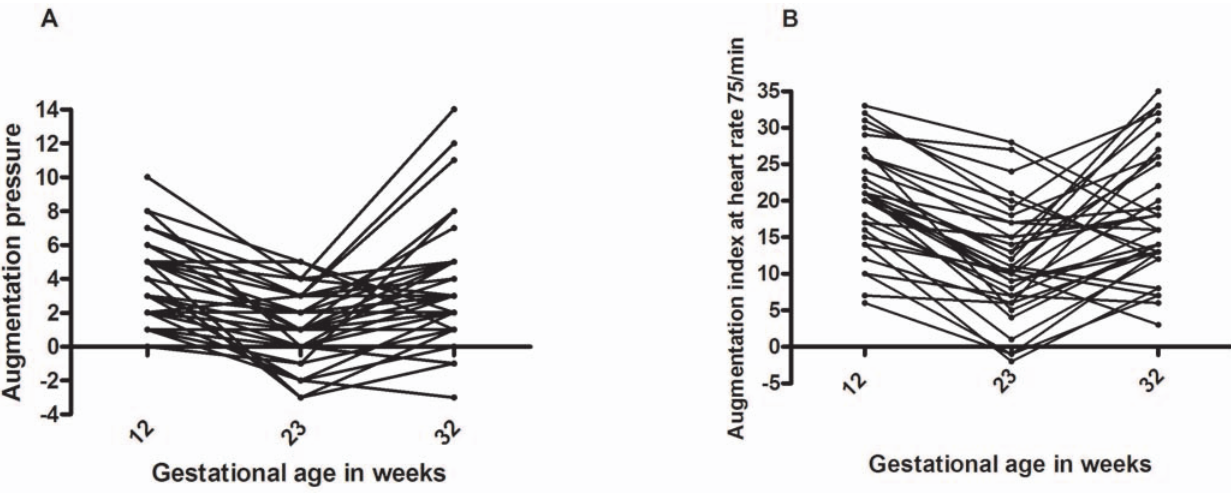
Figure 5. Longitudinal changes in pulse wave analysis parameters. Longitudinal data for the 45 women who had measurements taken at 12 + 0 –12 + 6 weeks, 23 + 0 –23 + 6 weeks, and 32 + 0 –32 + 6 weeks of gestation: (a) augmentation pressure (AP), and (b) augmentation index at heart rate 75 beats per minute (AIx-75).